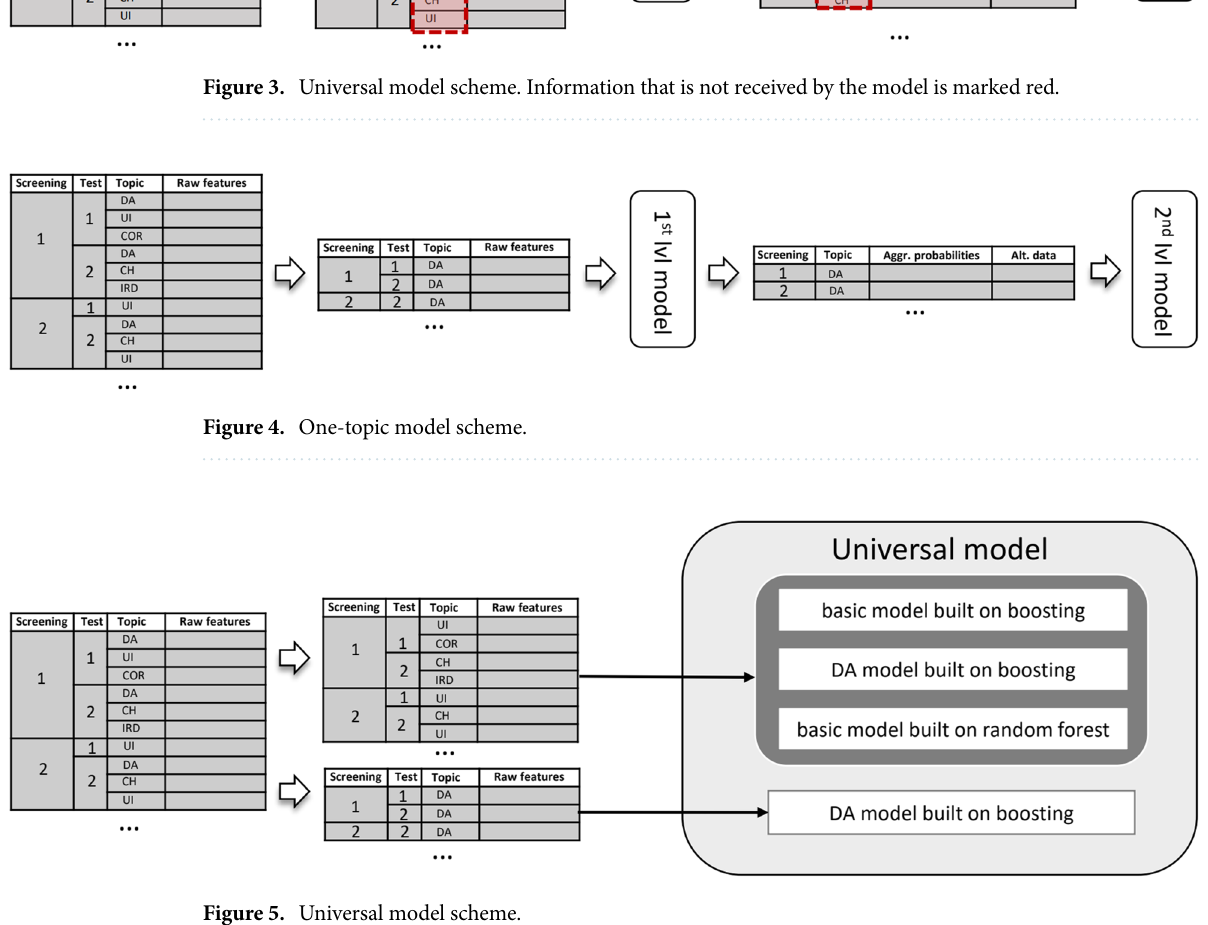
Figure 5. Universal model